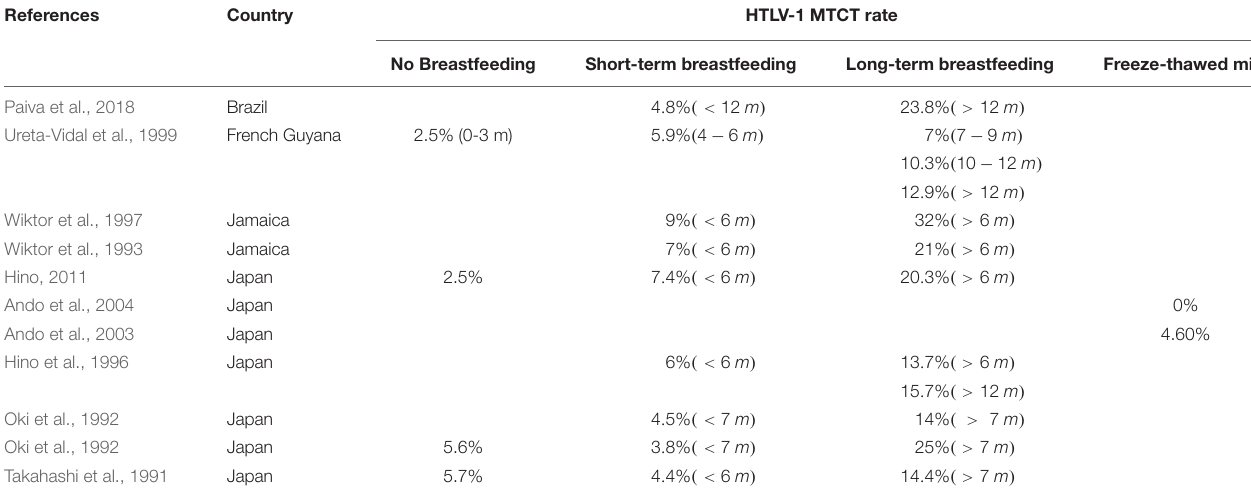
TABLE 2 | Rate of HTLV-1 mother-to-child transmission according to the duration of breastfeeding.